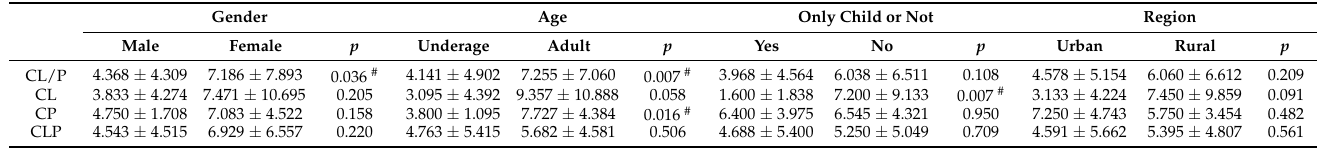
Table 4. Factors influencing the total PHQ-9 scores of patients with